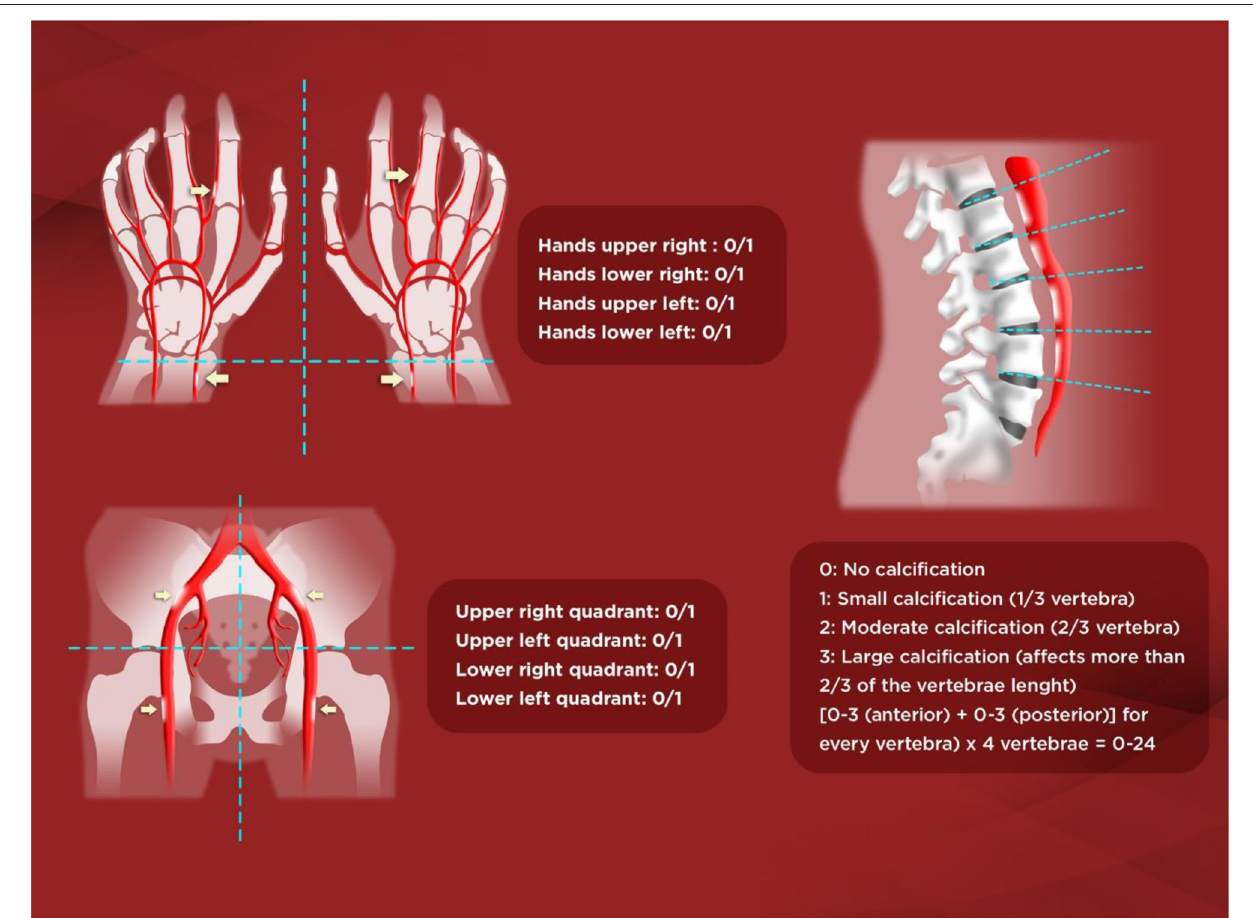
FIGURE 1 | Adragão and Kauppila scores. Kauppila score (KS) . The score is assigned from 1 to 3 [1: small calcification (1/3 of the vertebral length), 2: moderate (2/3), 3: large ( > 2/3)] depending on the length of each plaque detected. The anterior and posterior part of the aorta shall be taken into consideration, associating them with the place where they are located, in front of the L1, L2, L3, or L4 vertebrae. With KS, a final score is achieved between 0 and 24 points . Adrag ã o score (AS) . The score is determined by the sum of the absence of calcification (0 points), or the presence of unilateral (1 point) or bilateral (2 points) linear calcification in each section. AS analyzes the calcification of iliac, femoral, radial, and digital arteries. The final value ranges from 0 to 8 points (0–4 in the pelvis and 0–4 in the